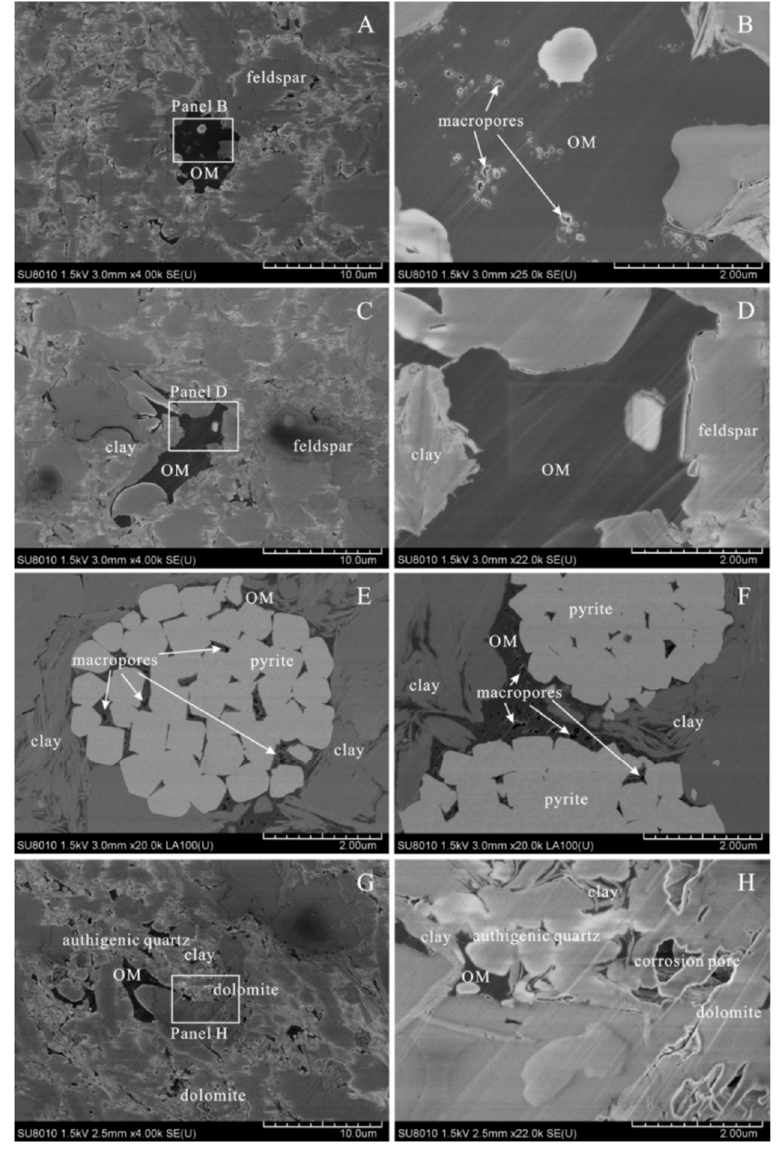
Figure 9. Field emission scanning electron microscopy (FE-SEM) images of the Niutitang shale sample JDS-75b (75.1 m, 246.4 ft, TOC = 3.68 wt.%, quartz = 28.0%, clay = 41.9%, excess SiO 2 = 15.01%). ( A , B ) Blocky OM grains with a few organic pores that exhibit poor connectivity. ( C , D ) OM grains without visible organic pores. ( E , F ) Various types of mesopores and macropores developed in OM patches occurring in framboidal pyrite or between framboidal pyrite particles. ( G , H ) Corrosion pores in carbonate minerals.